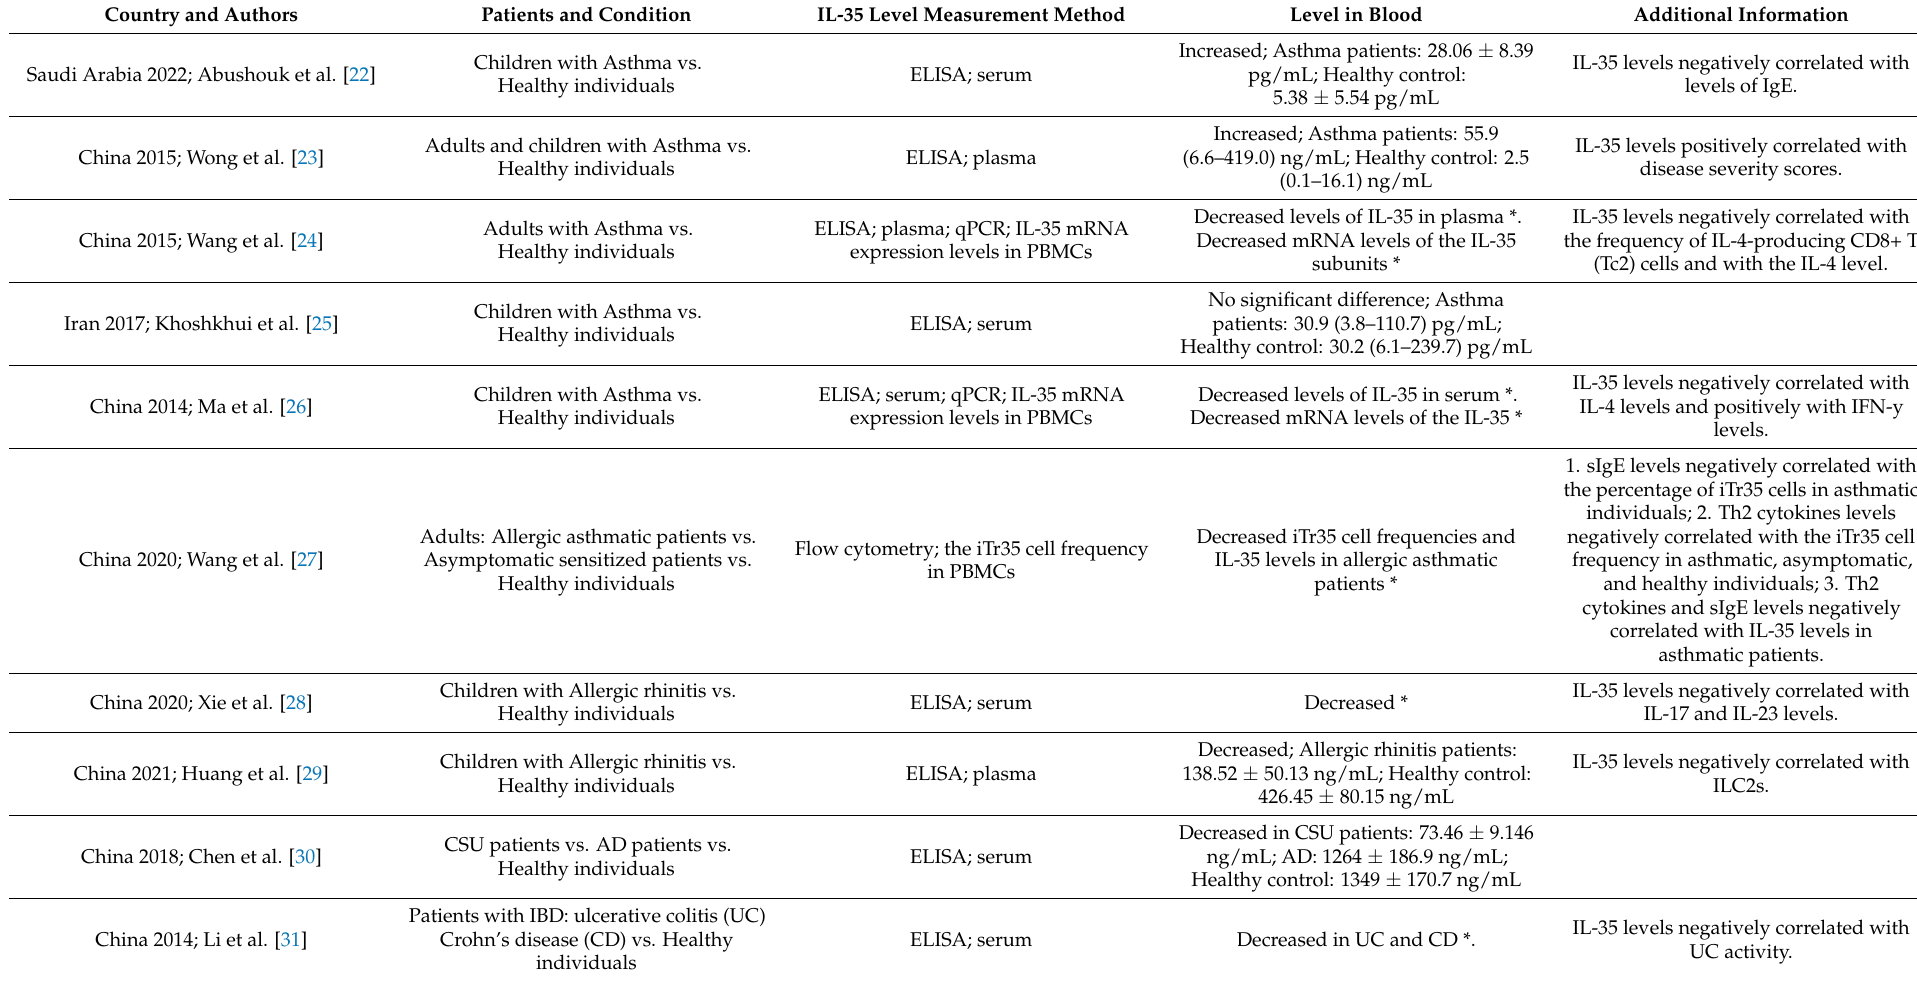
Table 1. IL-35 levels in some human